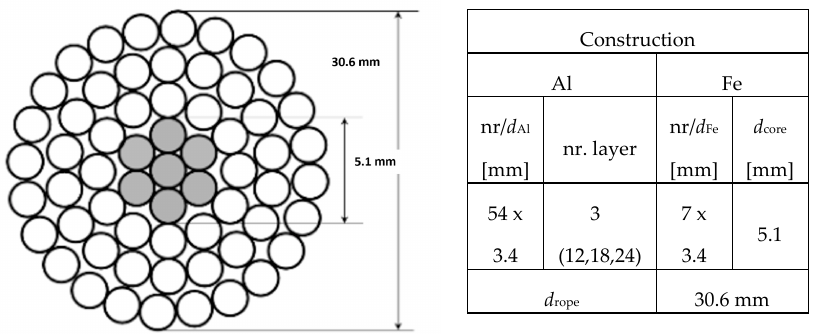
Figure 2. ACSR (aluminum conductor steel—reinforced) conductor Al/Fe 490/65 mm 2.